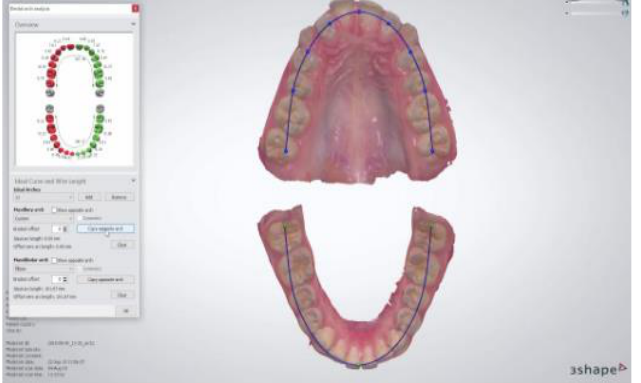
Figure 2. OrthoAnalyzer.